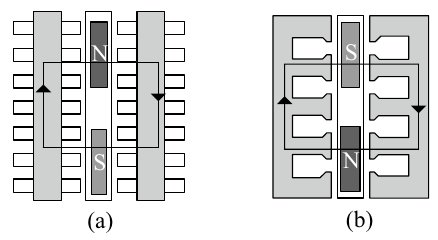
Figure 10 Magnetic circuits of an AFIR motor: a AFIR-NS and b